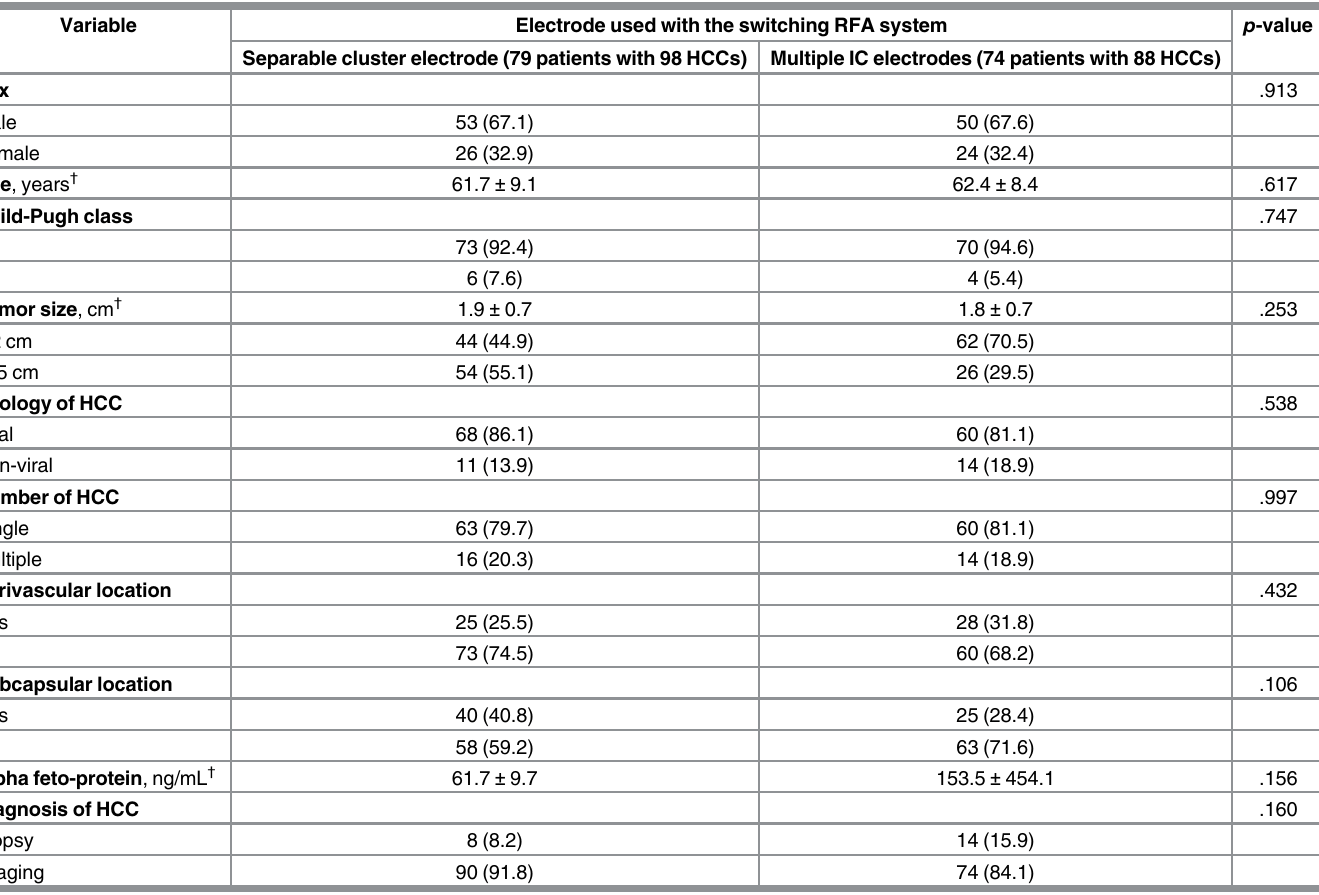
Table 1. Baseline characteristics of the study population.